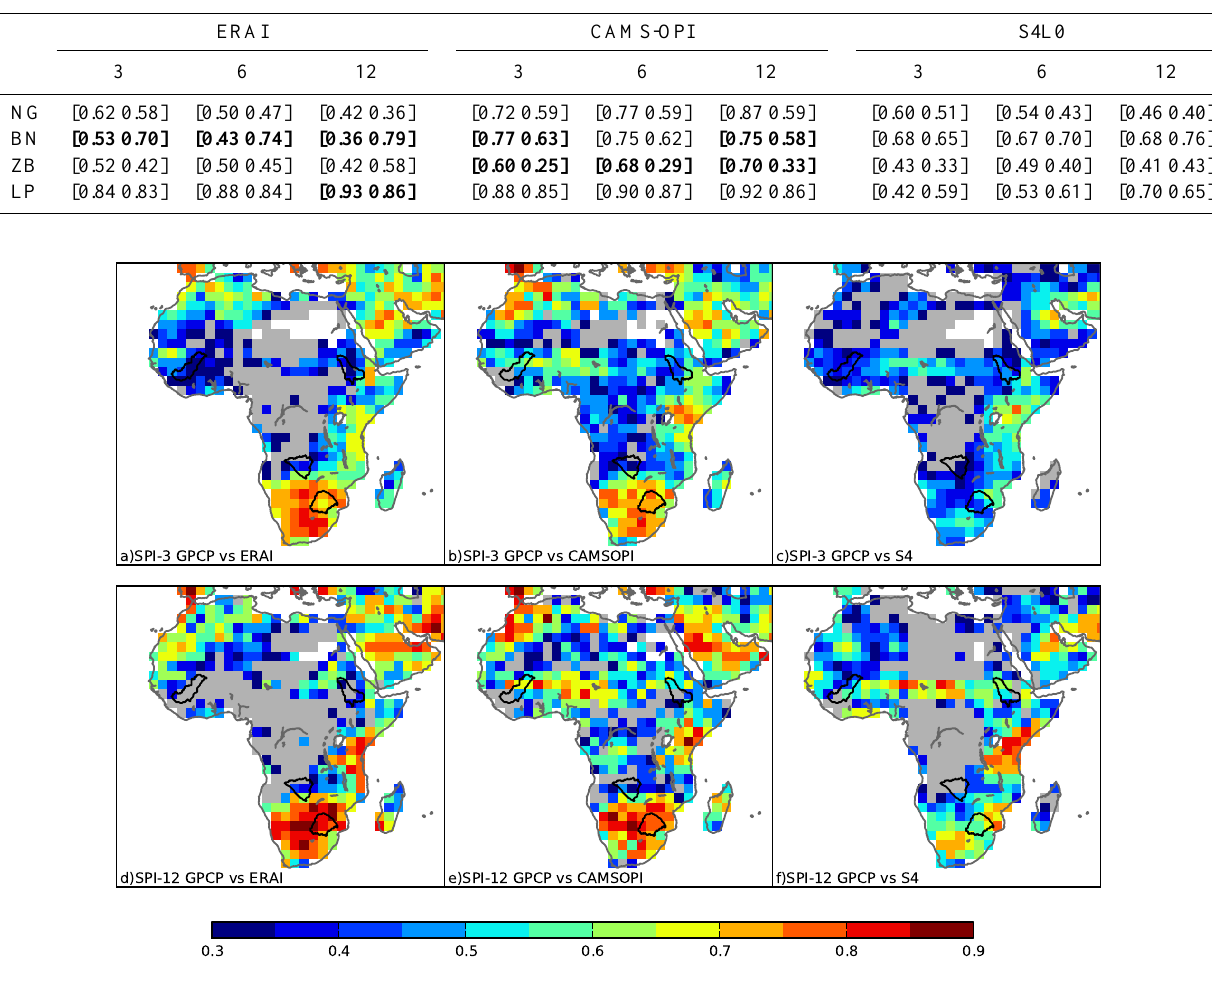
Fig. 5. Temporal correlation of (a–c) 3-month and (d–f) 12-month SPI between (a, d) GPCP and ERAI, (b, e) GPCP and CAMS-OPI, and (c, f) GPCP and S4. Gray areas denote statistically insignificant correlations with p >